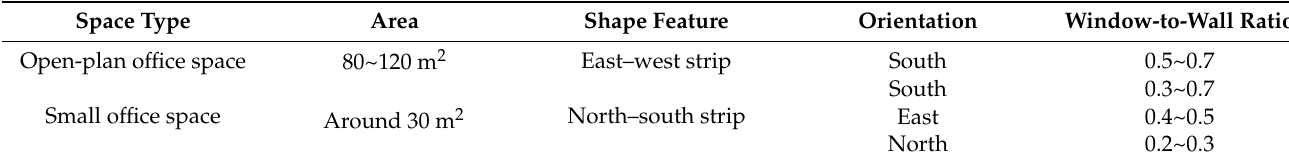
Table 3. Characteristics of the two types of office spaces.